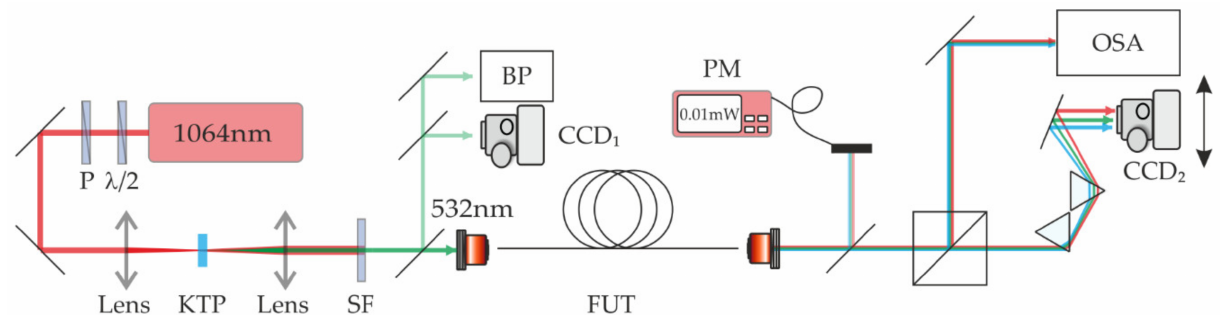
Figure 2. The experimental setup for the inter-modal FWM investigation in an FMF: P—polarizer, λ /2—half-wave plate, KTP—nonlinear crystal, SF—short pass filter, FUT—fiber under test, BP—beam profiler, PM—power meter, CCD—digital camera, OSA—optical spectrum analyzer. The FUT was kept straight to avoid external strain and stress-induced